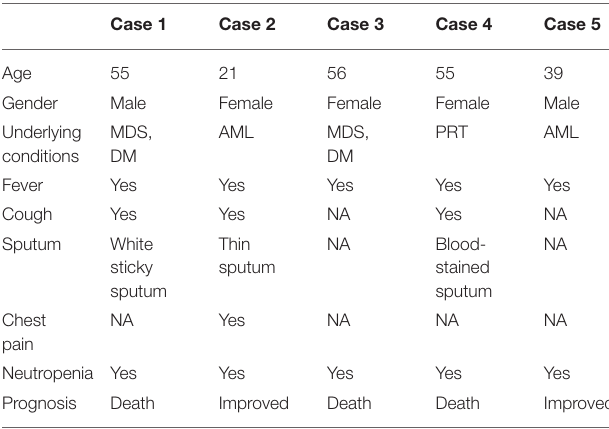
TABLE 1 | Demographic and clinical